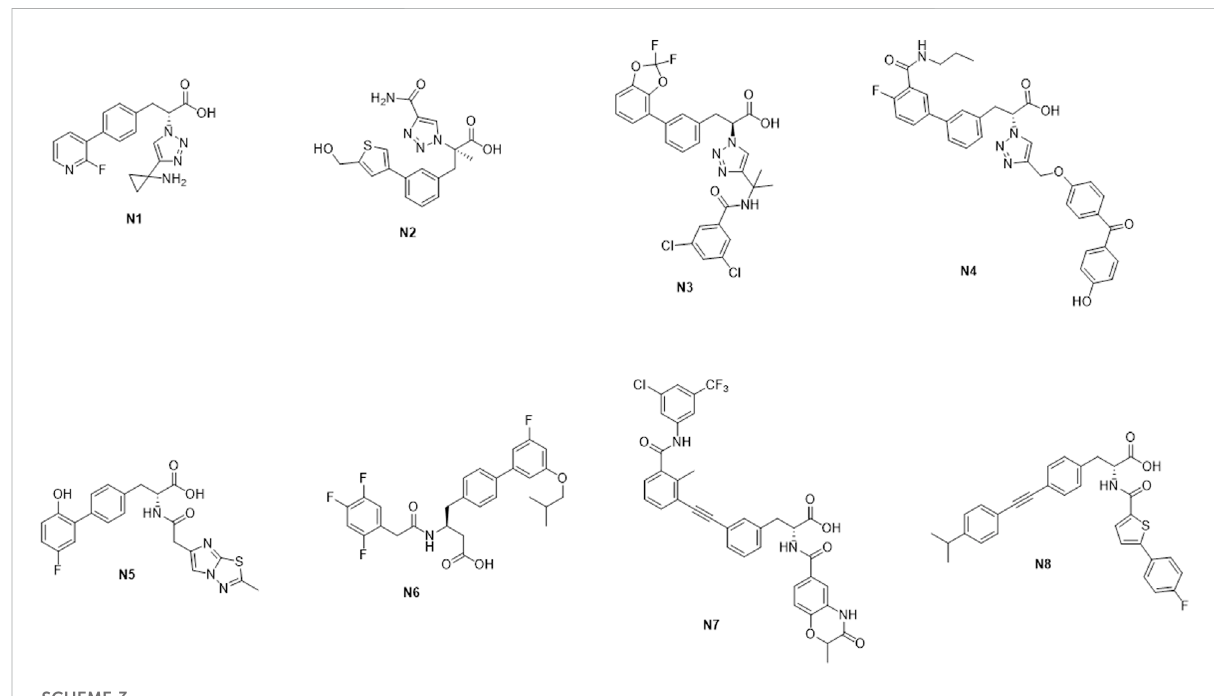
TABLE 4 The calculated binding energy of N1-N8 binding to